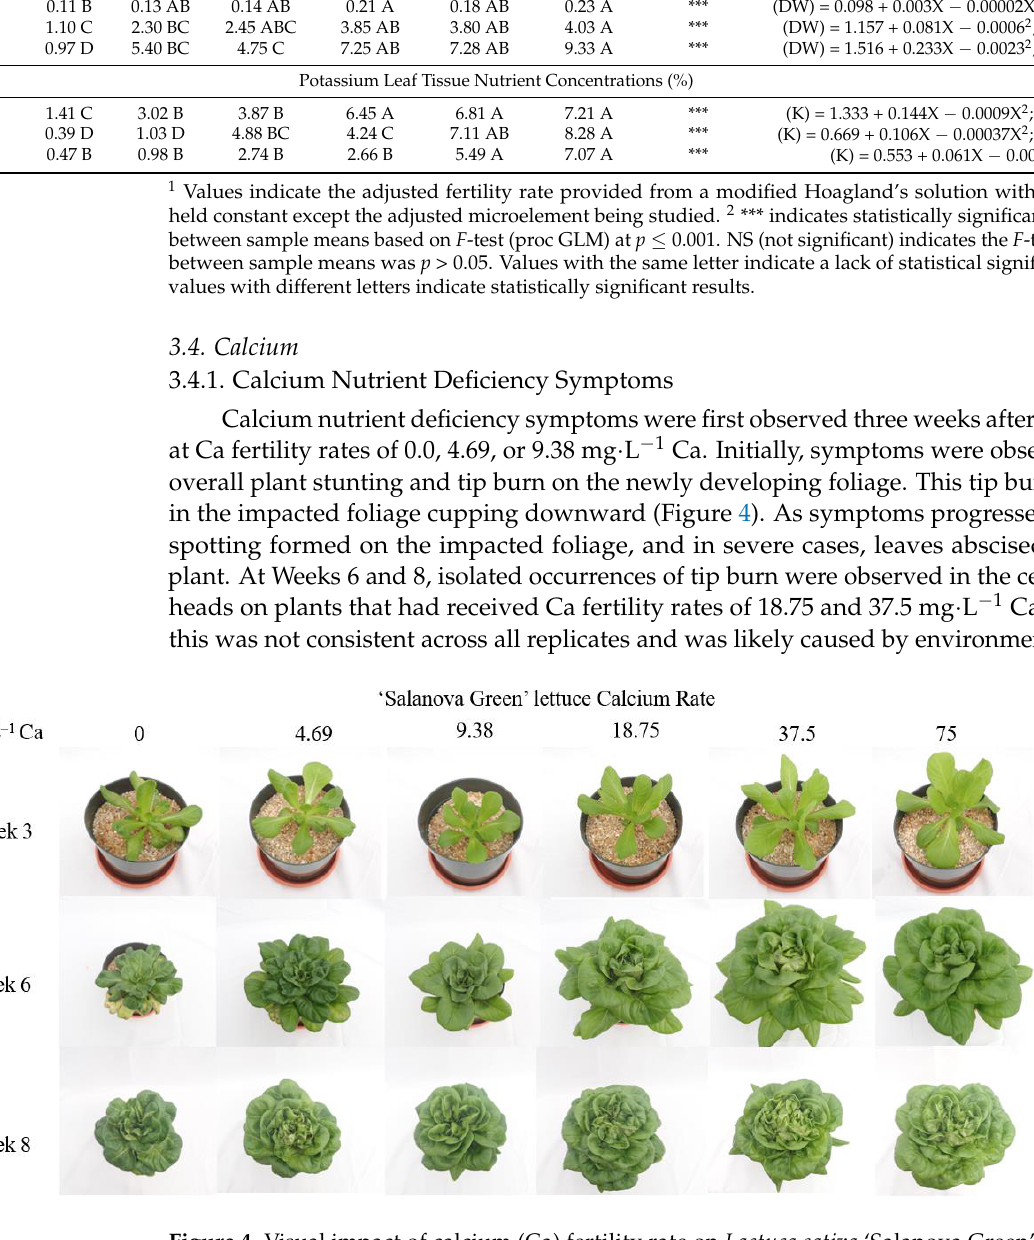
Figure 4. Visual impact of calcium (Ca) fertility rate on Lactuca sativa ‘Salanova Green’ at Weeks 3, 6, and 8. Table 5. Impact of calcium fertility rate on plant dry weight and calcium leaf tissue concentration on ‘Salanova Green’ lettuce.